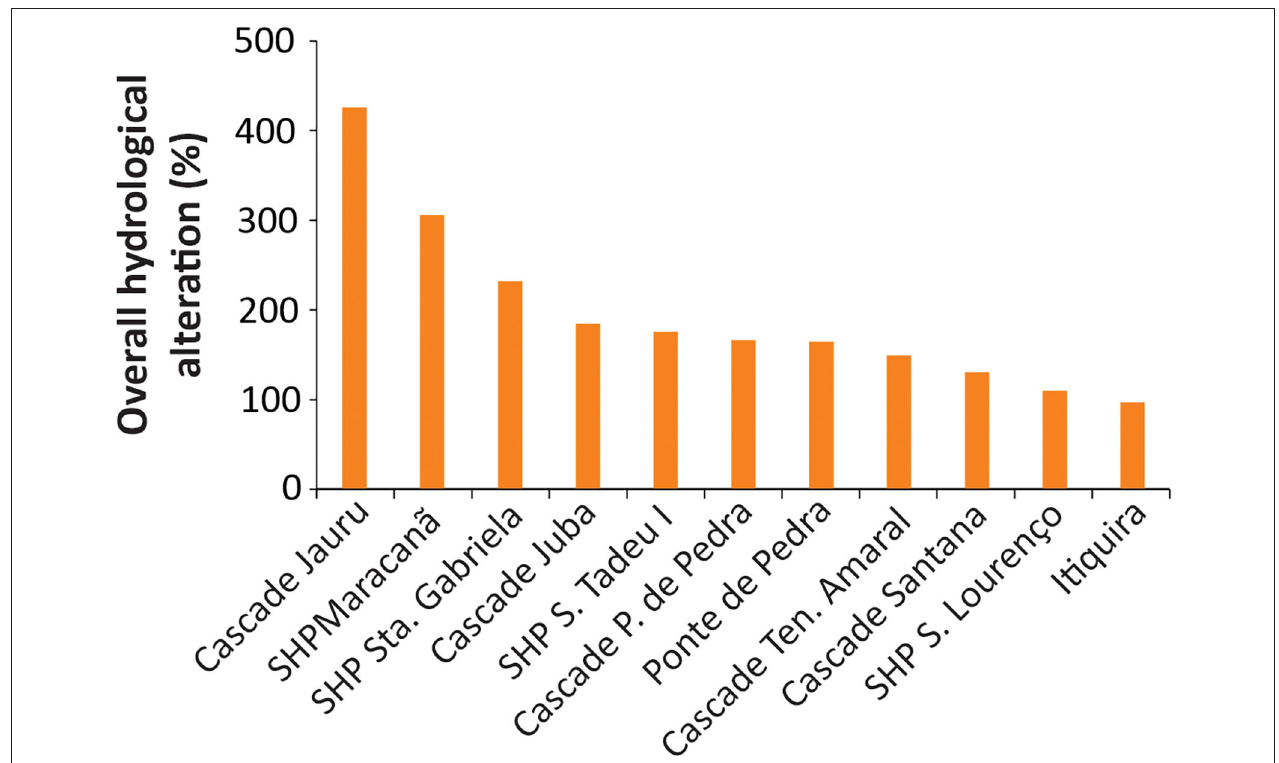
FIGURE 5 | Overall hydrological alteration (HA overall) across all indicators and months for each hydropower facility (in the five reaches containing more than one facility, the labels show the name of the facility that is closest to the downstream gaging station).